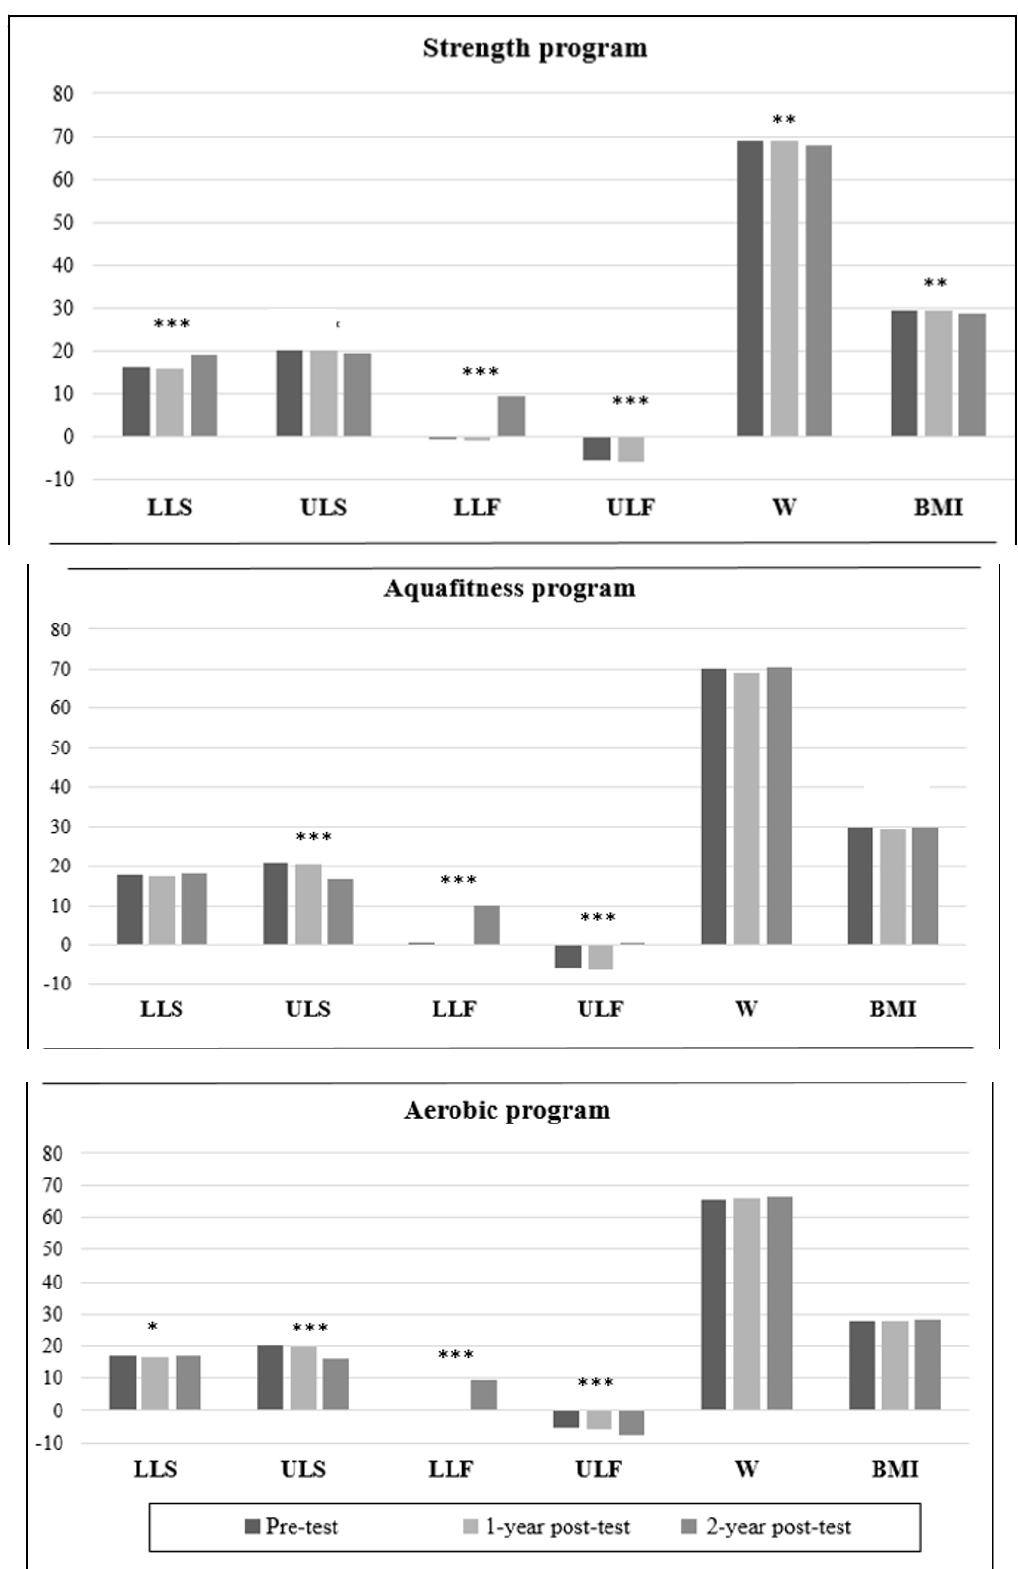
Figure 3. Senior Fitness Test, weight and body mass index results by intervention group. (LLS: lower limbs strength; ULS: upper limbs strength; LLF: lower limbs flexibility; ULF: upper limbs flexibility; W: weight; BMI: body mass index). Comparison between initial test vs. final test: * p < 0.05; ** p < 0.01; *** p < 0.0001.